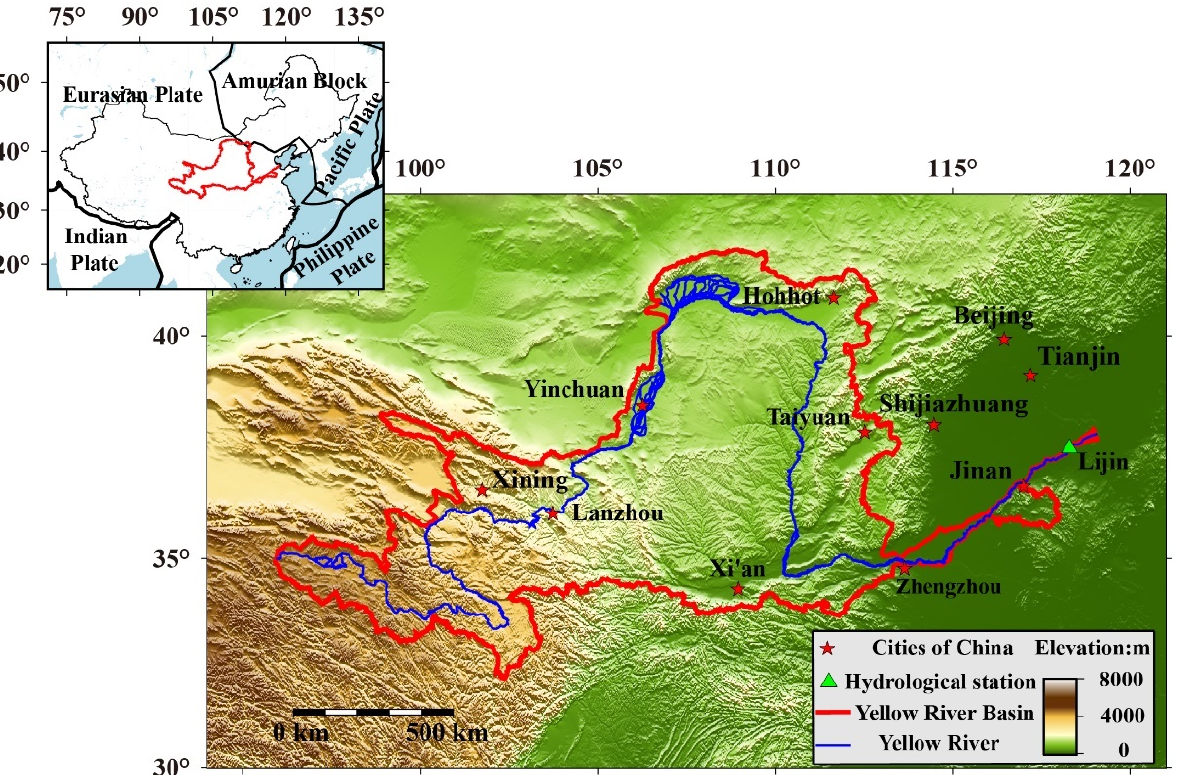
Figure 1. Boundary of the Yellow River Basin and the location of important hydrological stations.